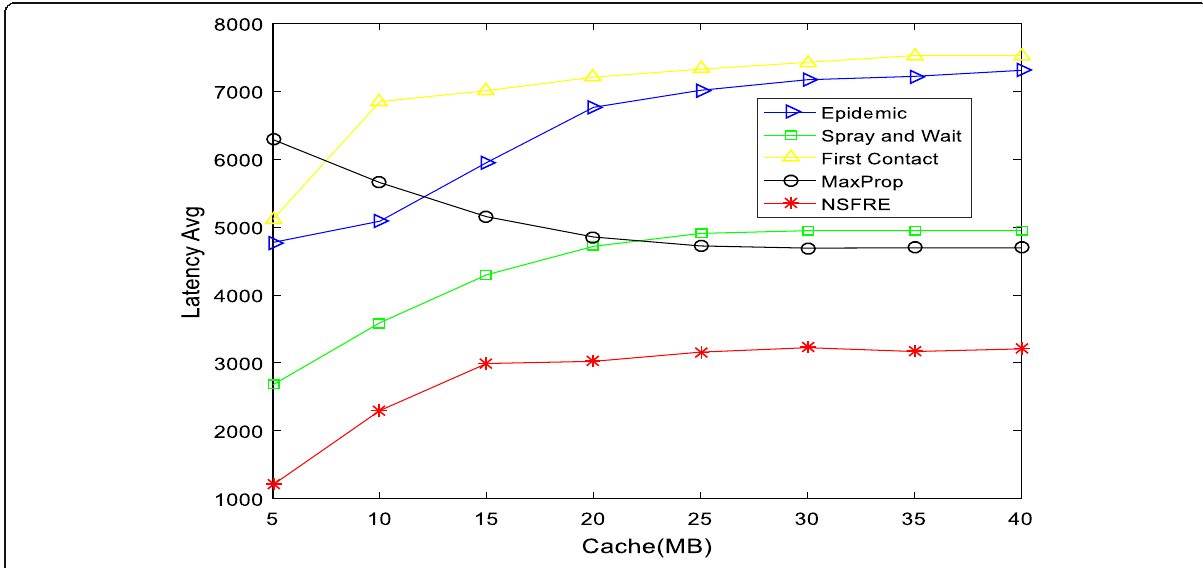
Fig. 12 The relationship between the average transmission delay and the node